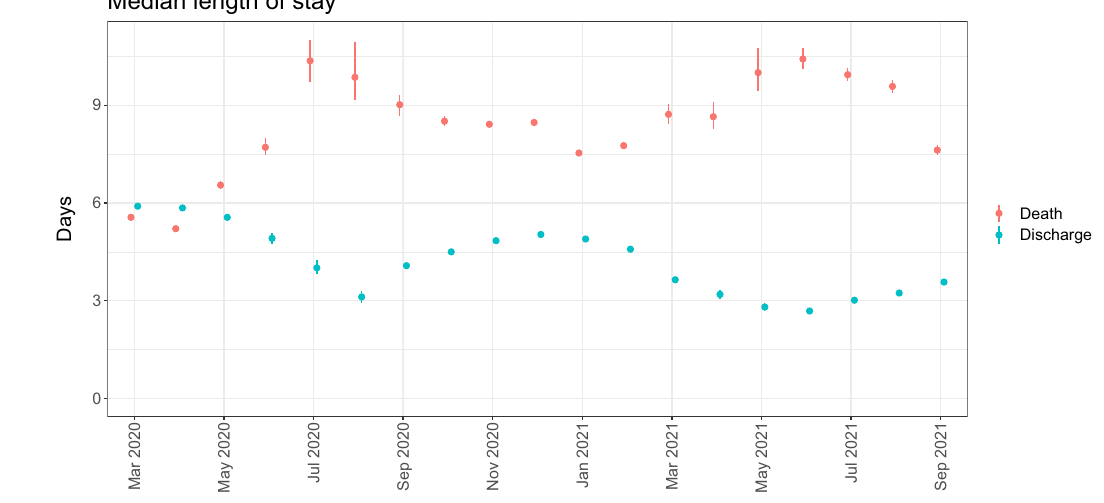
Fig.3|Hospitalisedfatalityriskandmedianlengthofstaybymonthofhospital admission.a Hospitalisedfatalityriskand b medianlengthofstayinhospitalprior